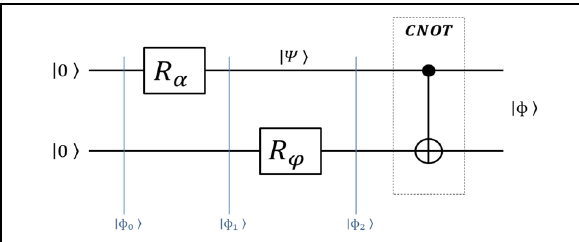
Fig. 1. Quantum circuit simulating the influence of context